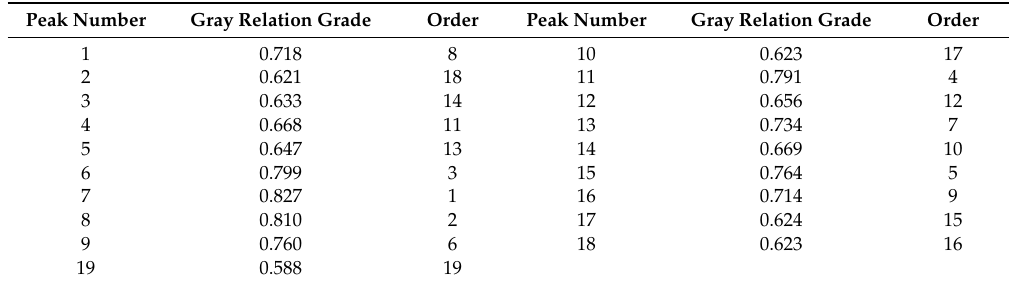
Table 6. The gray relationship grade and their order between 19 peak areas and antitumor e ff ect of toad venom extracts.